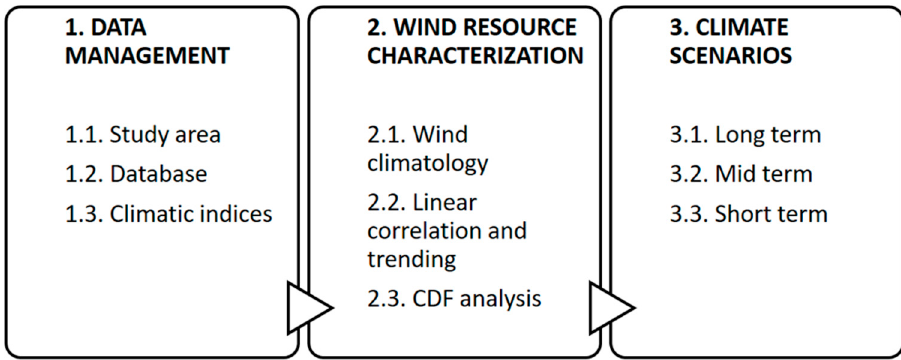
Figure 1. Proposed methodology for identifying the climatic scenarios from the lowest wind speed values.